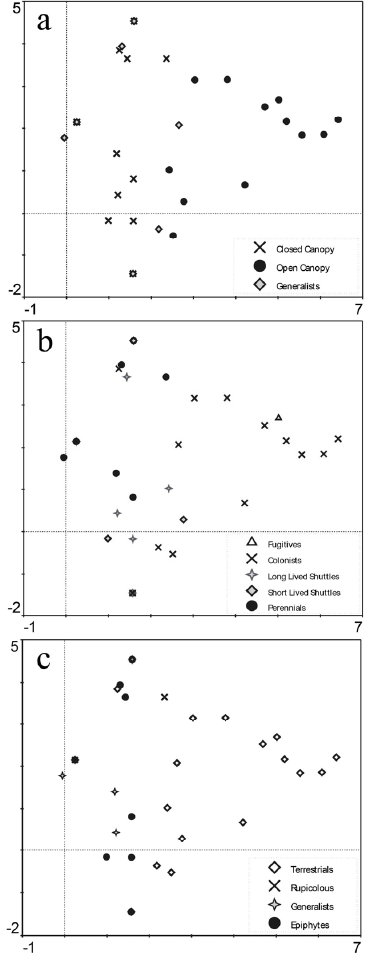
Figure 4. Detrended correspondence analysis (DCA) showing the distribution of all bryophyte species found in the plots classified by ( a ) canopy preference; ( b ) life strategy; and ( c ) substrate preference.